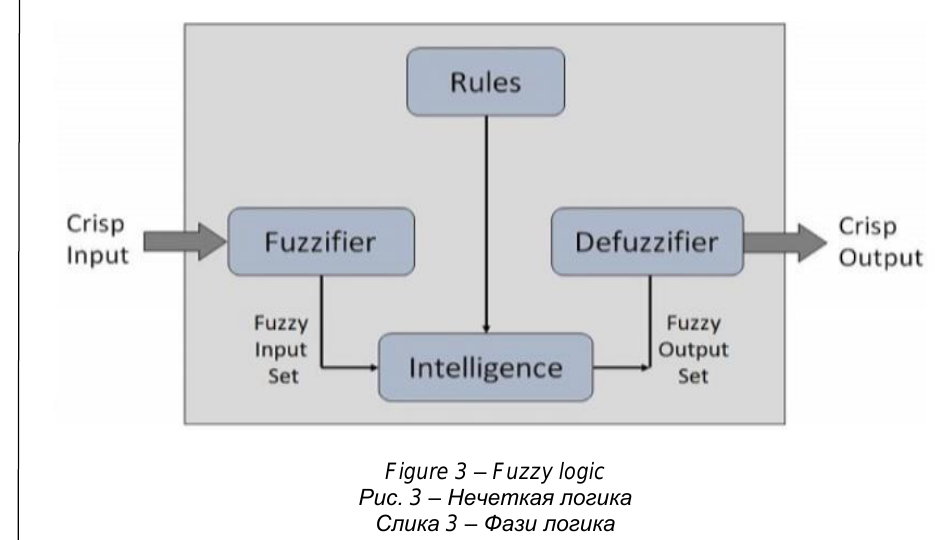
Figure 3 – Fuzzy logic Рис. 3 – Нечеткая логика Слика 3 – Фази